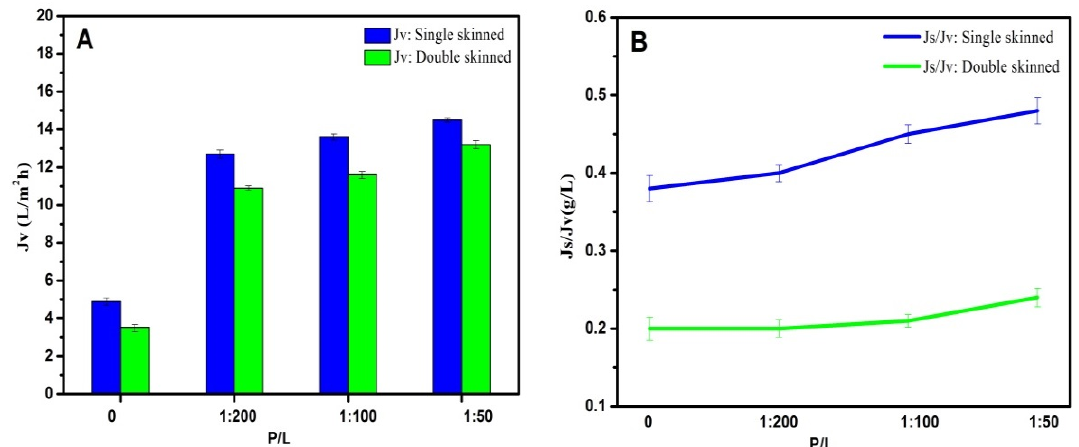
Figure 7. FO performances of AqpZ-incorporated single-skinned and double-skinned FO membranes in the FO mode. ( A ) J v of AqpZ-incorporated single-skinned and double-skinned FO membranes; ( B ) J s / J v of AqpZ-incorporated single-skinned and double-skinned FO